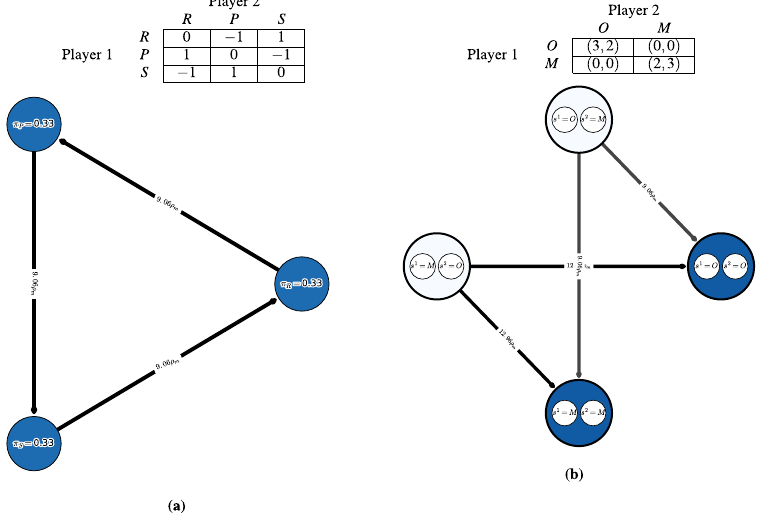
Figure 3. Conceptual examples of finite-population models, for population size = m 50 and ranking-intensity α = . 0 1 . (a) Payoffs (top) and single-population discrete-time dynamics (bottom) for Rock-Paper-Scissors game. Graph nodes correspond to monomorphic populations R, P, and S. (b) Payoffs (top) and multi- population discrete-time dynamics (bottom) for Battle of the Sexes game. Strategies O and M respectively correspond to going to the Opera and Movies. Graph nodes correspond to monomorphic population profiles (s1; s2). The stationary distribution p has 0.5 mass on each of profiles (O;O) and (M;M), and 0 mass elsewhere.